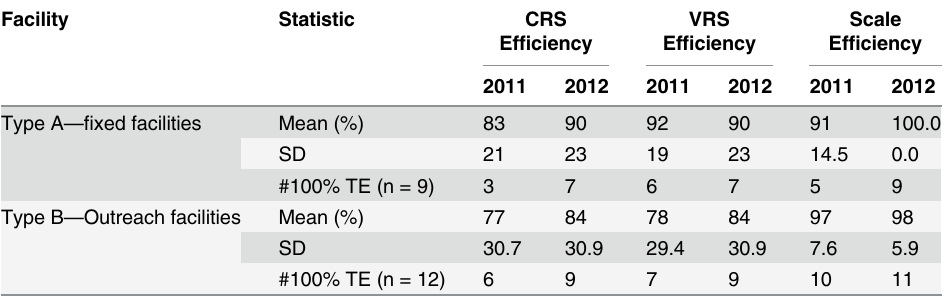
Table 4. Summary of facility performance scores by type and year.